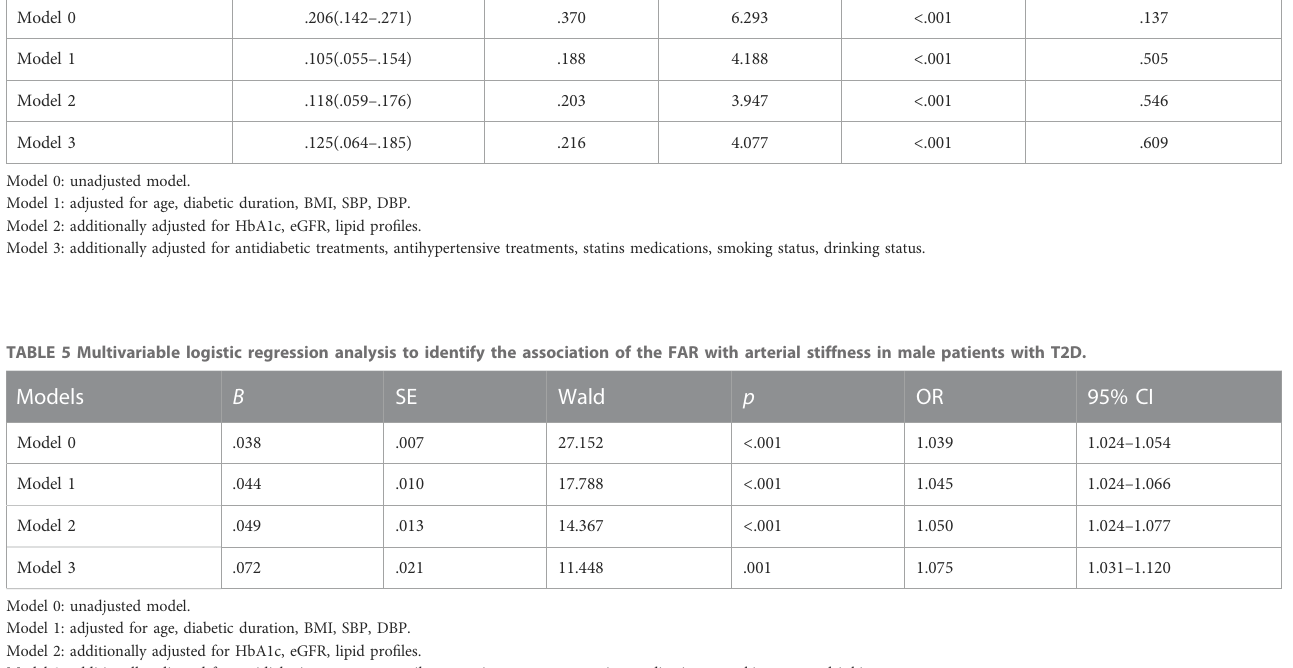
TABLE 4 Multiple linear regression models displayed independent associations of the lnFAR with lnbaPWV in male patients with T2D. Models B (95% CI) β t p R 2 for model Model 0 .206(.142 – .271) .370 < .001 .137 Model 1 .105(.055 – .154) .188 4.188 < .001 .505 Model 2 .118(.059 – .176) .203 3.947 < .001 .546 Model 3 .125(.064 – .185) .216 4.077 < .001 .609